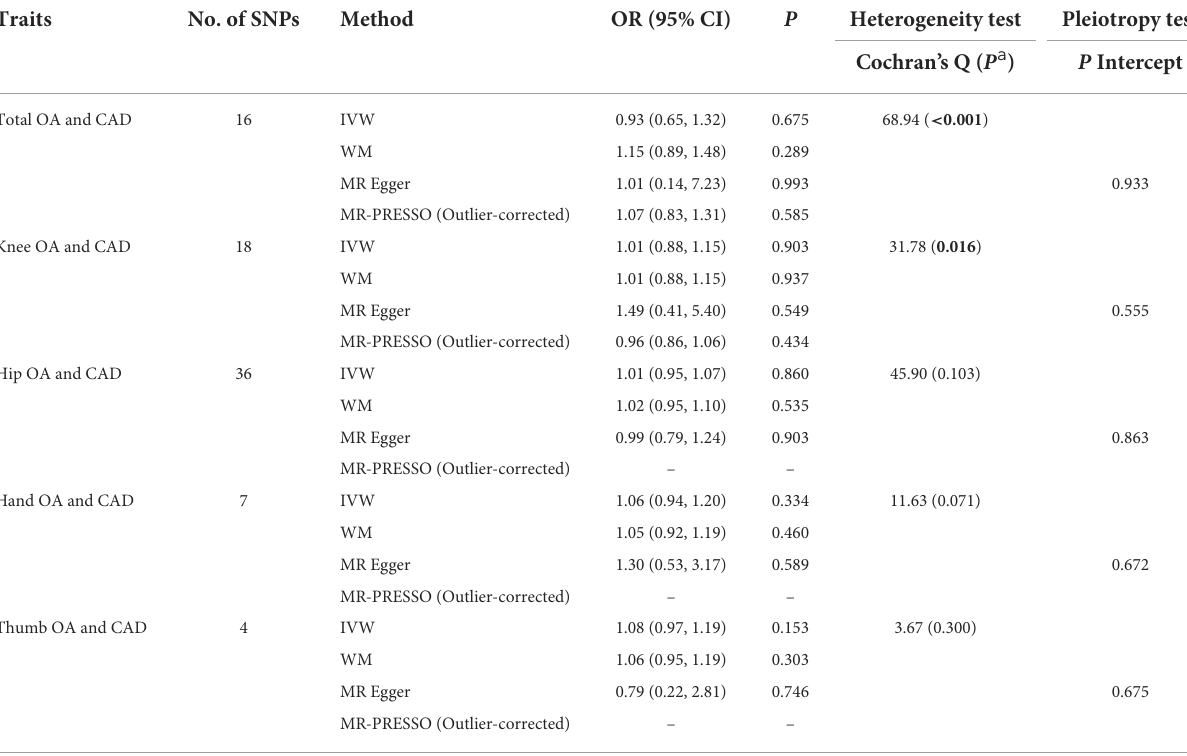
TABLE 2 MR results of the association between OA and CAD.